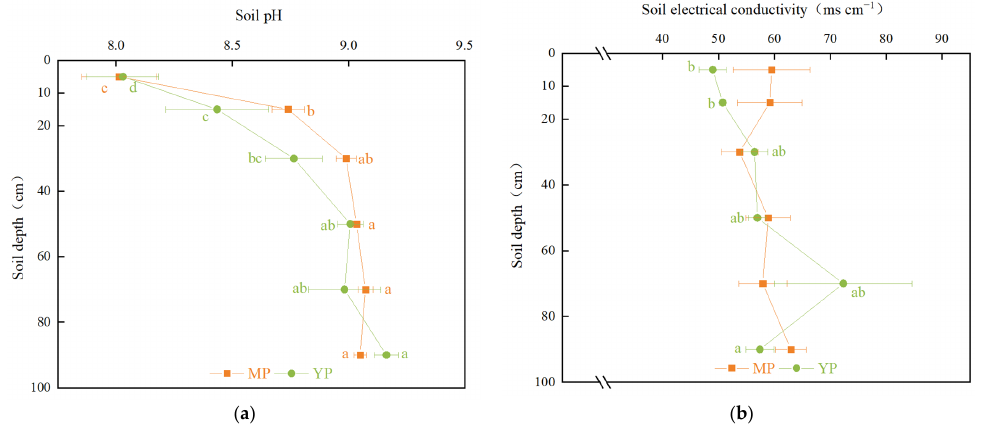
Figure 5. Changes of soil pH ( a ) and soil electrical conductivity ( b ) along 0 − 100 cm soil profiles in the mature (MP) and young poplar (YP) plantations. Different lowercase letters denote significant differences among different depths within the same plantation; while different uppercase letters denote significant differences between different plantations within the same soil depth ( p < 0.05).